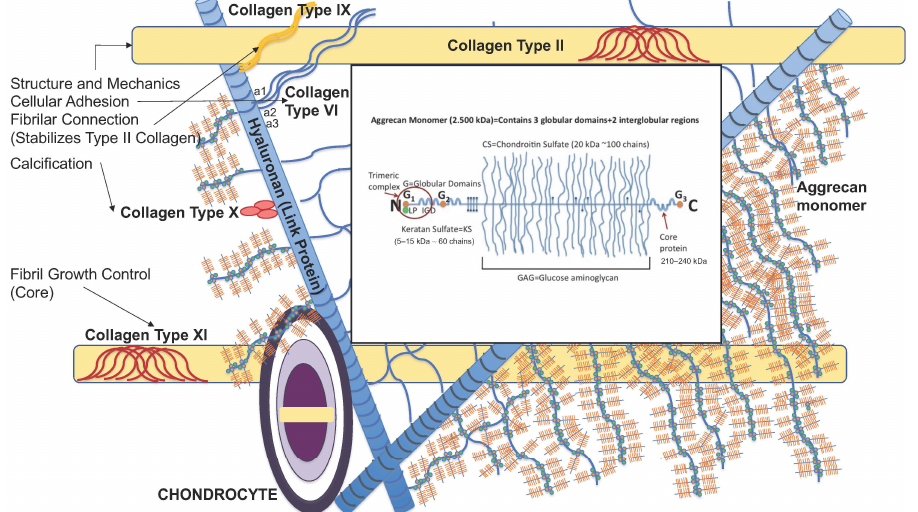
Figure 1. Structure of articular joint cartilage.